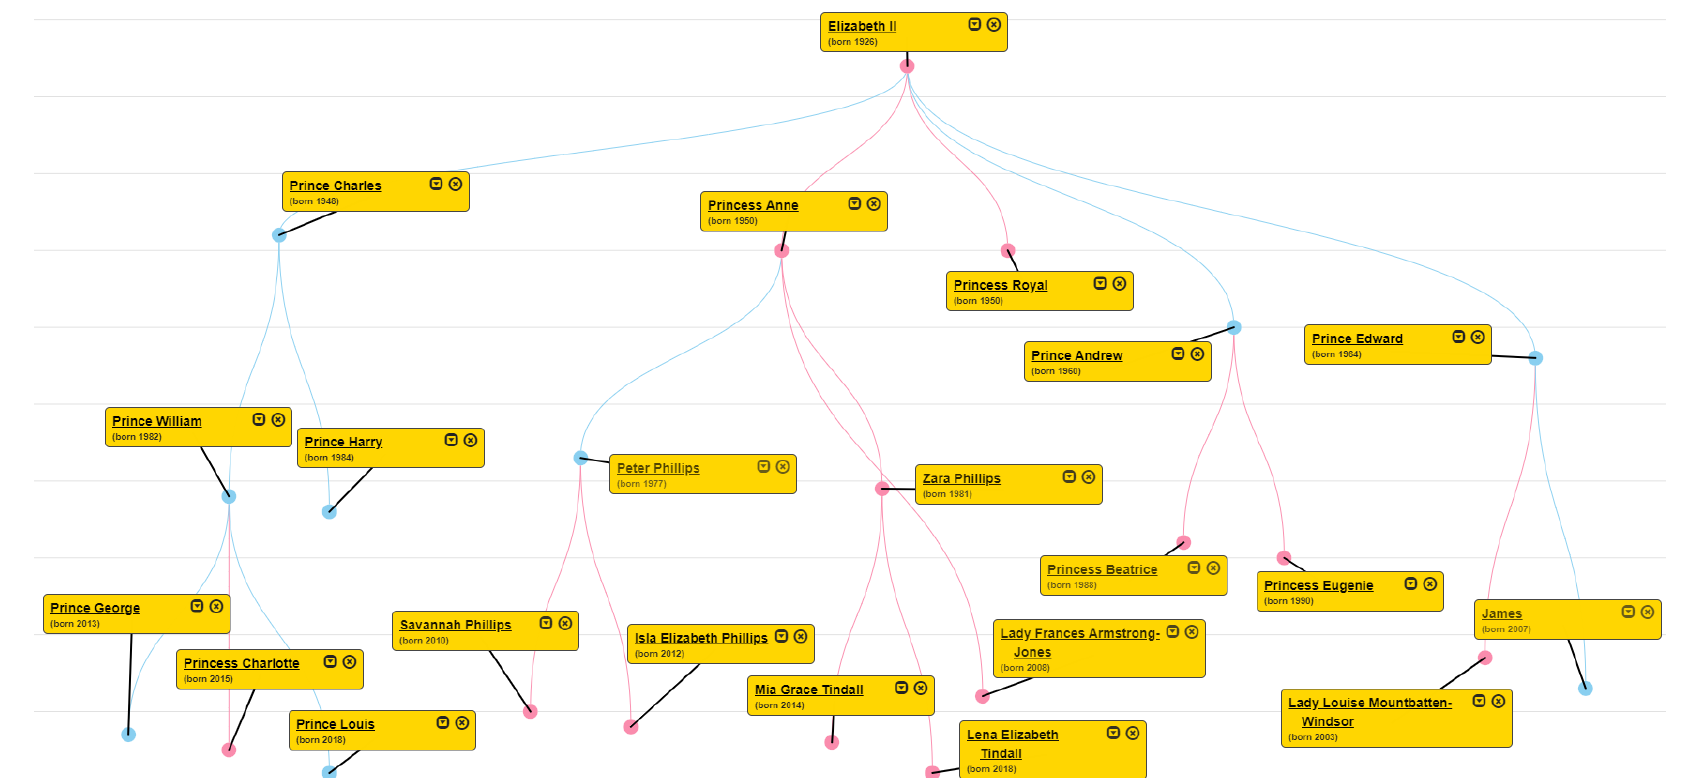
Figure 4. Family tree with Queen Elizabeth as root and her